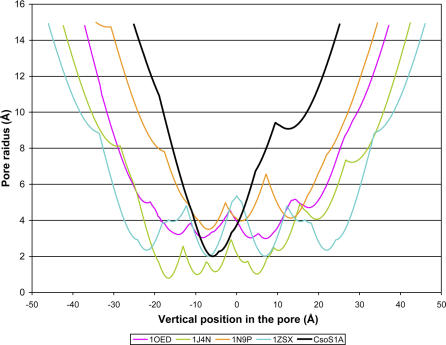
Calculated Radius of the Central Pore through CsoS1A, Shown in Comparison to the Pores through Transmembrane Channel ProteinsIn each case, the radius of the pore is plotted as a function of the vertical position in the layer. CsoS1A is indicated in black and compared to the acetylcholine receptor pore (1OED), the aquaporin1 water channel (1J4N), the cytoplasmic domain of the inward rectifier potassium channel 1 (1N9P), and the human potassium channel Kv β-subunit (1ZSX). The CsoS1A pore is much shorter in length and more conical in shape than the pores through transmembrane channel proteins. The position of the CsoS1A curve along the horizontal axis was chosen arbitrarily.